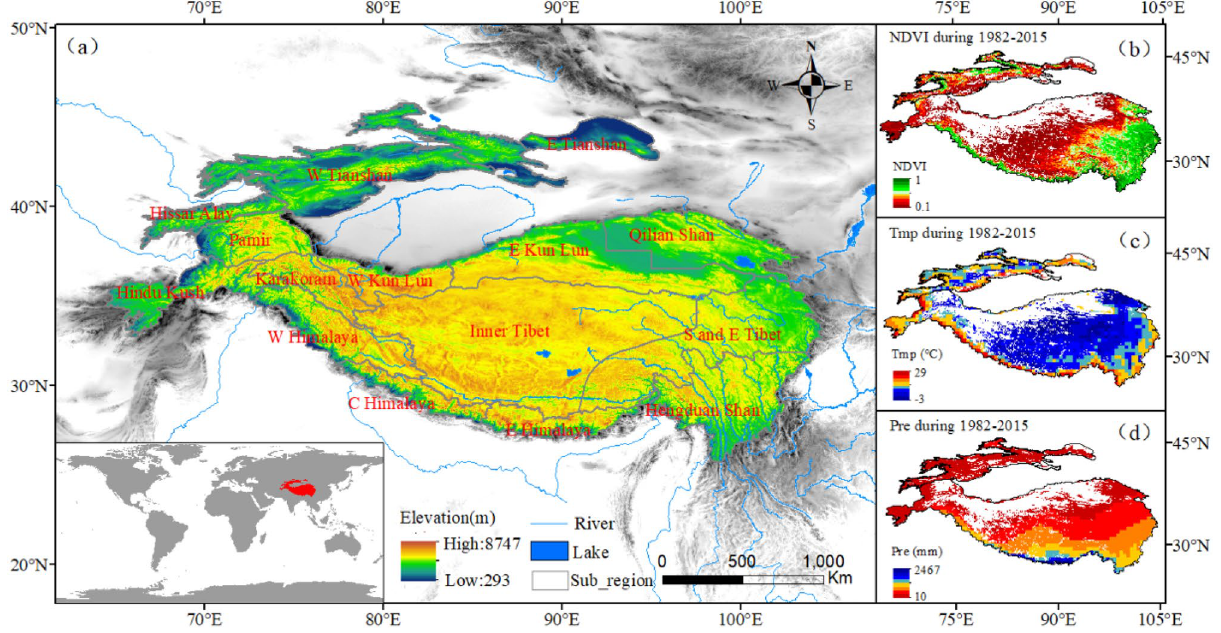
Figure 1. Study area. ( a ) High Mountain Asia (HMA), which mainly includes the Tibetan Plateau (TP), Tianshans, Pamir Plateau, Kunlun Mountains and Qilian Mountains. Spatial distribution of ( b ) NDVI, ( c ) air temperature (Tmp) and ( d ) precipitation (Pre) in HMA growing season from 1982 to 2015. Data sources: NASA and CRU (Generated by ArcGIS 10.3, URL: http:// www. esri. com/ softw are/ arcgis/ arcgis- for- deskt